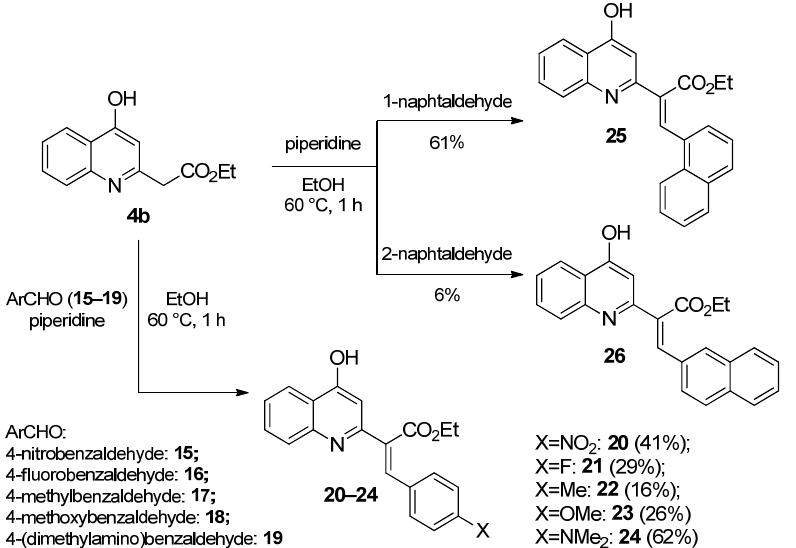
Scheme 5. The reaction of 4 ‐ hydroxyquinolines with aromatic aldehydes in the presence of piperi